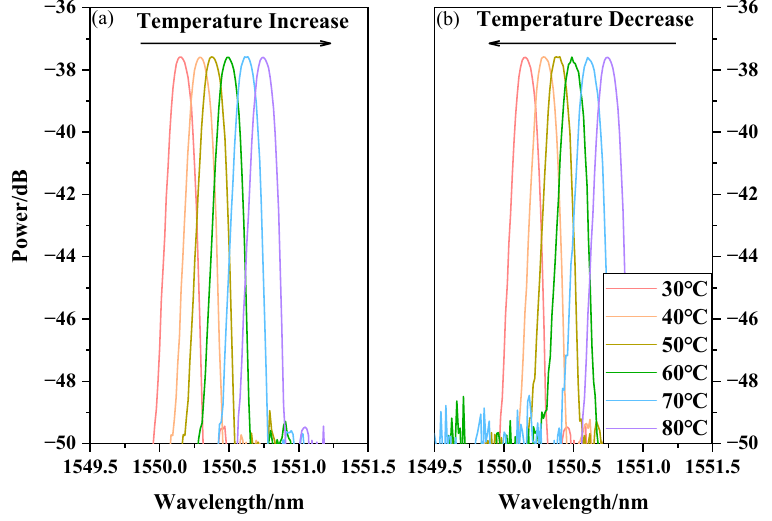
Figure 12. Temperature response with temperature increase and decrease. ( a ) Temperature Increase; ( b ) Temperature Decrease.